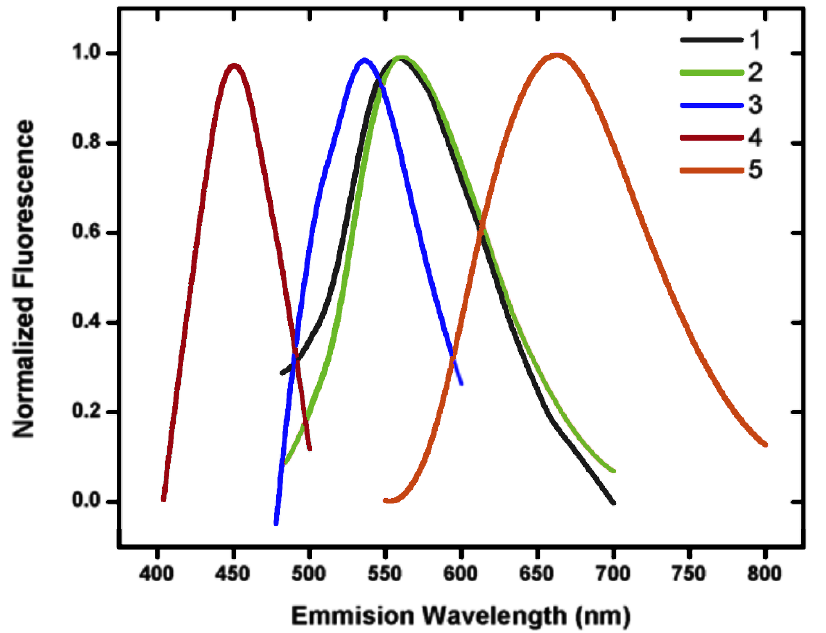
Figure 4. Normalized fluorescence emission spectra for Compounds 1 – 5.